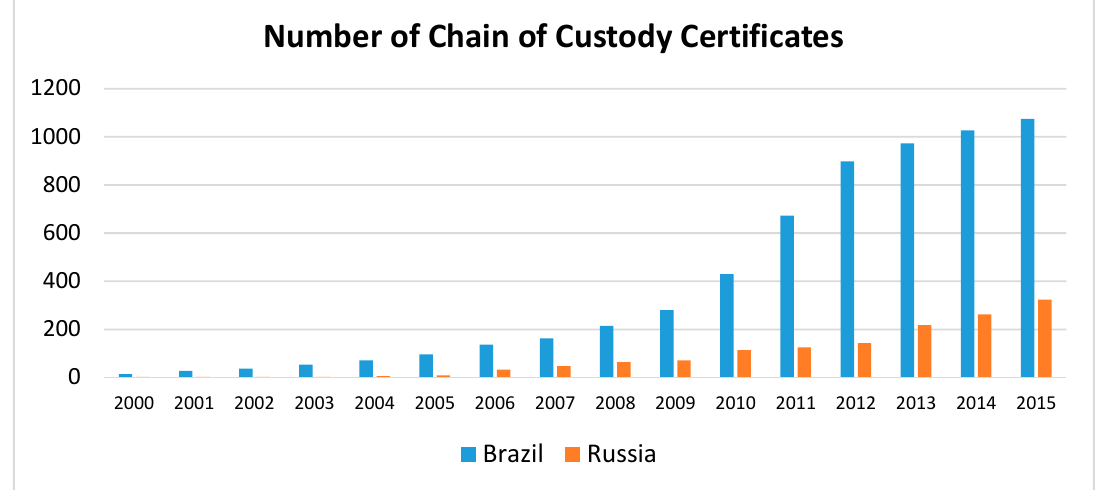
Figure 1. Total area (in hectares) of Forest Stewardship Council (FSC)-certified forest territory in Brazil and Russia, 2000–2015. Source: FSC International.